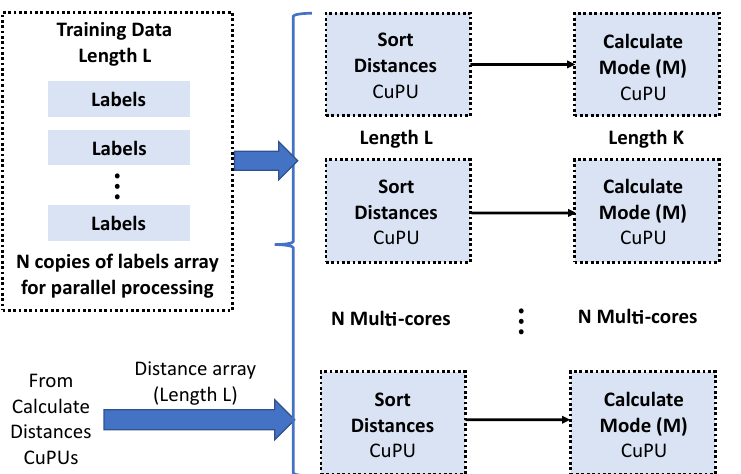
Figure 3. Sort Distances and Calculate Mode CuPUs by processing N symbols. The labels are copied N times to be operated in